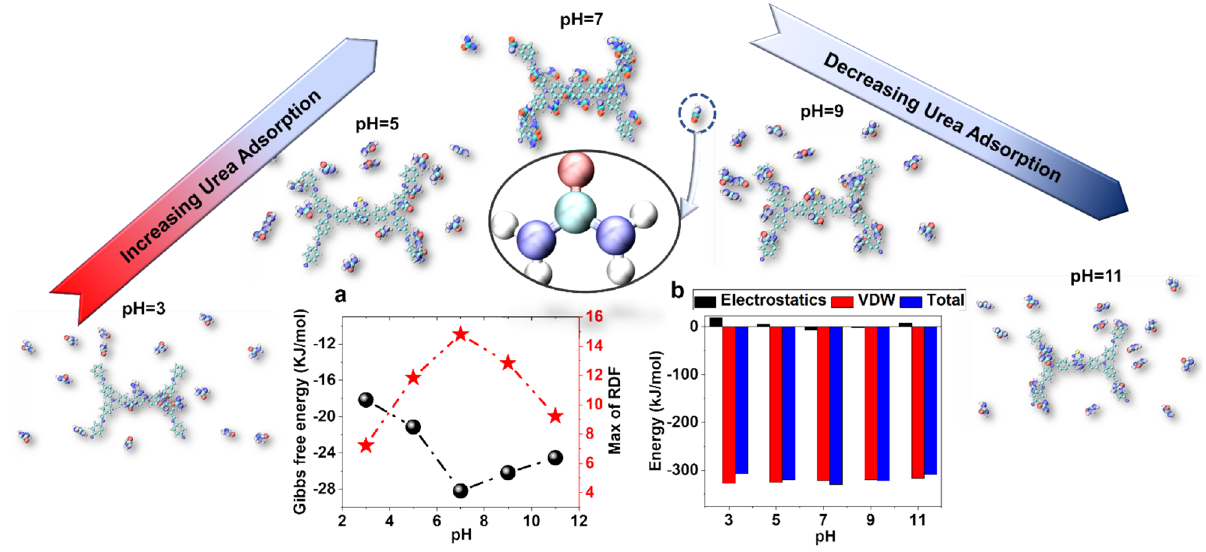
Figure 7. ( a )The Gibbs free energy and maximum RDF of urea adsorption on the surface of TPA-COF in the different pH. ( b )The adsorption energy of urea on the surface of TPA-COF in the different